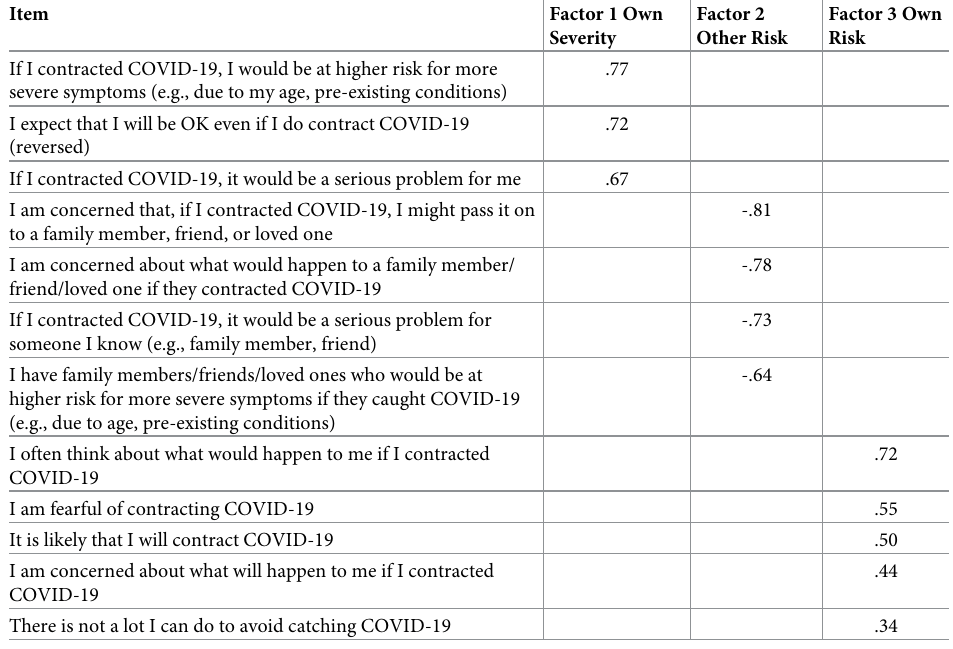
Table 6. Item loadings for a forced three-factor model for perceptions of risk using Principal Axis Factoring.